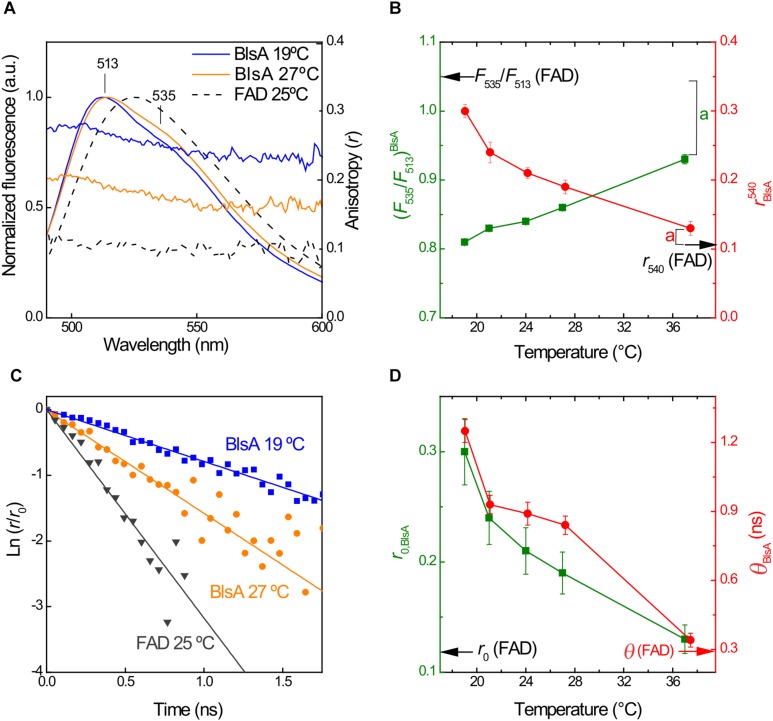
Temperature affects rigidity of the environment surrounding FAD in dBlsA. (A) Normalized fluorescence emission spectra of dBlsA at 19 and 27°C and FAD at 25°C in air-saturated buffer solution obtained by excitation at 460 nm. (B) Temperature dependence of the fluorescence intensity ratio between 535 nm and 513 nm (F535/F513) and steady-state anisotropy at 540 ± 20 nm (r540) for dBlsA. Arrows indicate the respective values for FAD and the respective steady state anisotropy. (C) Logarithmic first-order plots of the fluorescence anisotropy decays of dBlsA at 19 and 27°C monitored at 510 nm and FAD at 25°C monitored at 525 nm. (D) Temperature dependence of the initial anisotropy (r0) and the rotational correlation time (θ) for the cofactor in dBlsA. The data shown are mean ± SD of two independent measurements from two different protein productions. Letter (a) represents significant difference (p < 0.05) between dBlsA and free FAD at the indicated temperature points (B,D).